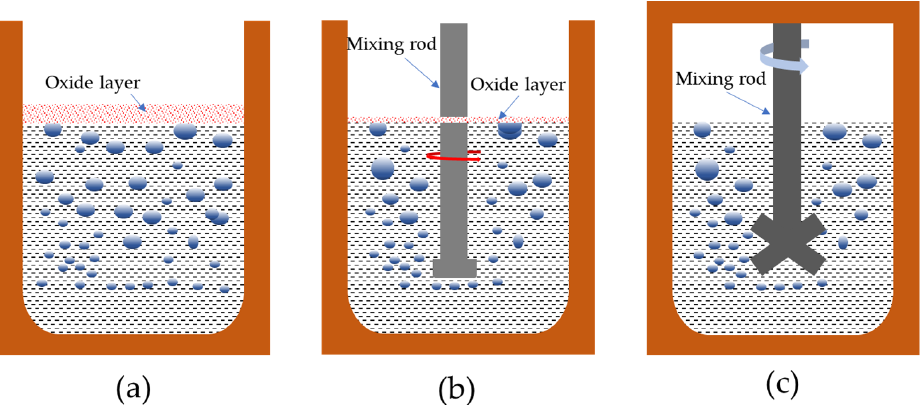
Figure 7. Different melt treatment processes of Al-6Mg alloy: ( a ) non-vacuum static melt treatment, ( b ) non-vacuum rotary-injection purification, ( c ) vacuum-stirring purification.